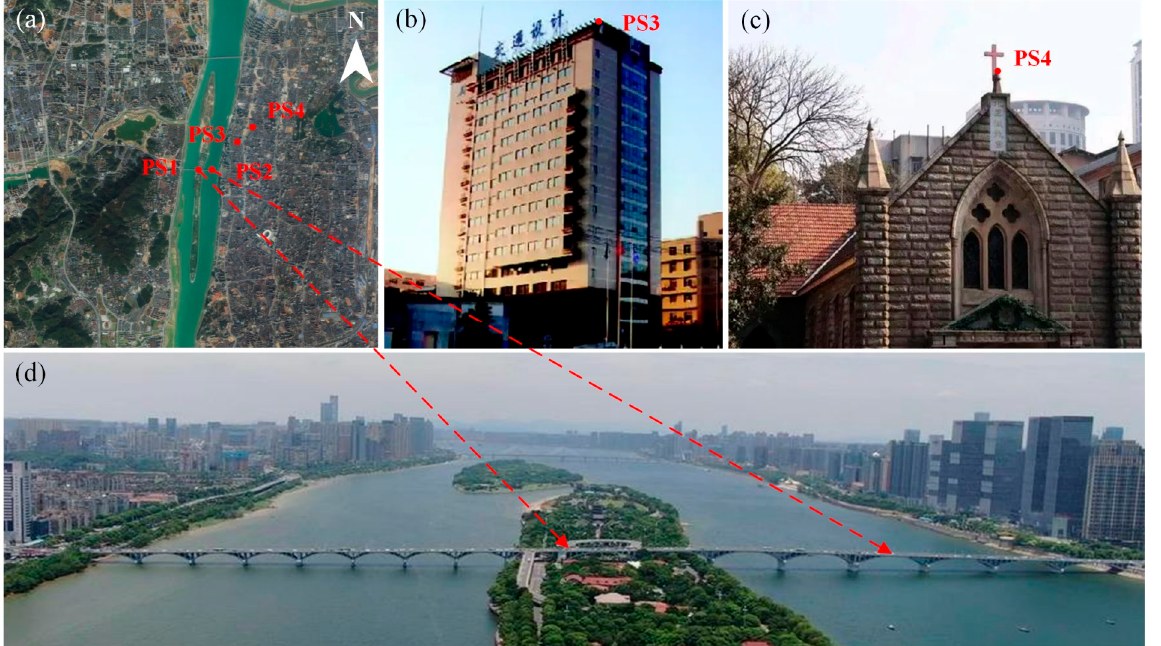
Figure 12. Locations of PS points and in situ pictures. ( a ) Location of the four PS points, ( b ) Location of PS3, ( c ) Location of PS4, and ( d ) Location of PS1, PS2.